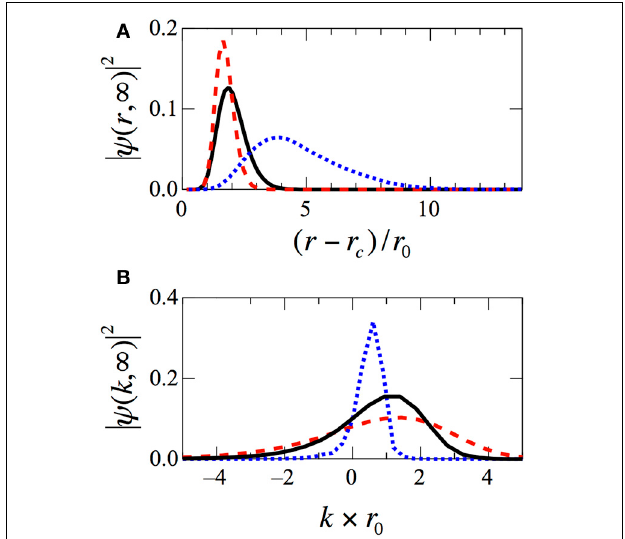
FIGURE 5 | Steady states corresponding to the potentials of Figure 2. (A) Probability distribution of relative distances; (B) corresponding relative momenta distributions. Black solid line: (cid:2) = γ / 4, (cid:3) = γ / 20; blue dotted line: (cid:2) = γ / 2, (cid:3) = γ / 40; red dashed line: (cid:2) = γ / 12, (cid:3) = γ / 20. The cutoff radius r c = r 0